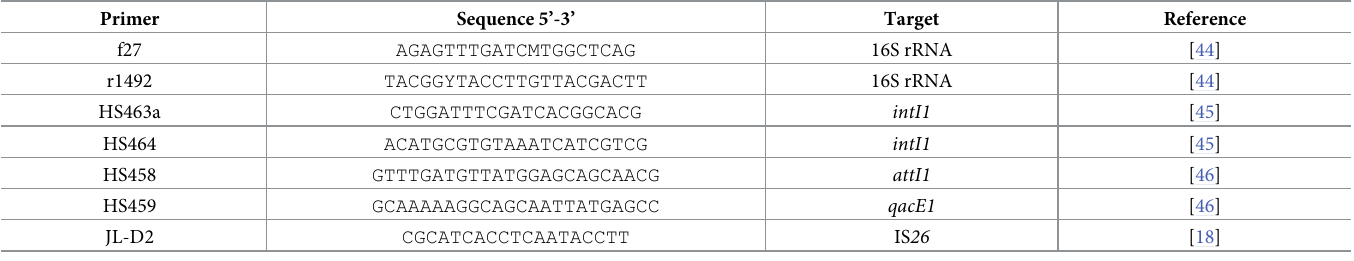
Table 2. PCR primers and target